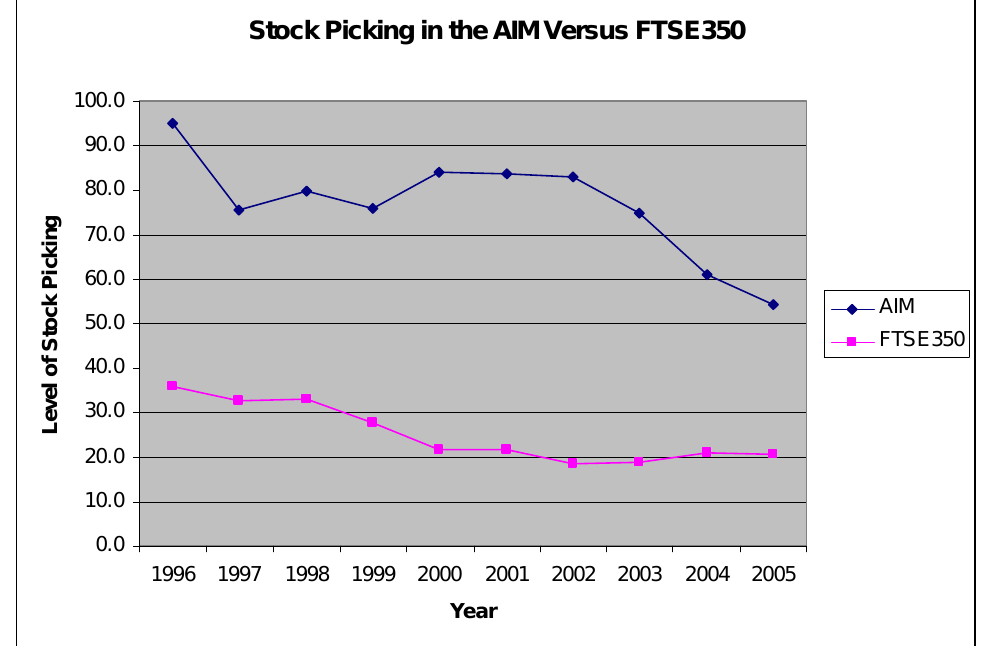
Figure 3: (Maximum Proportion of) Stock-Picking in the FTSE350, AIM for the period 1996-2005